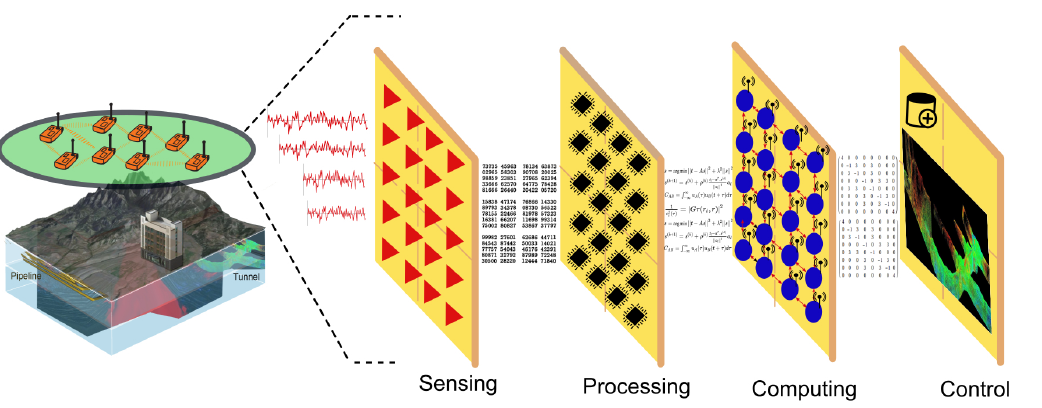
Figure 1. Subsurface Camera (SAMERA) system architecture: sensing, processing, computing and